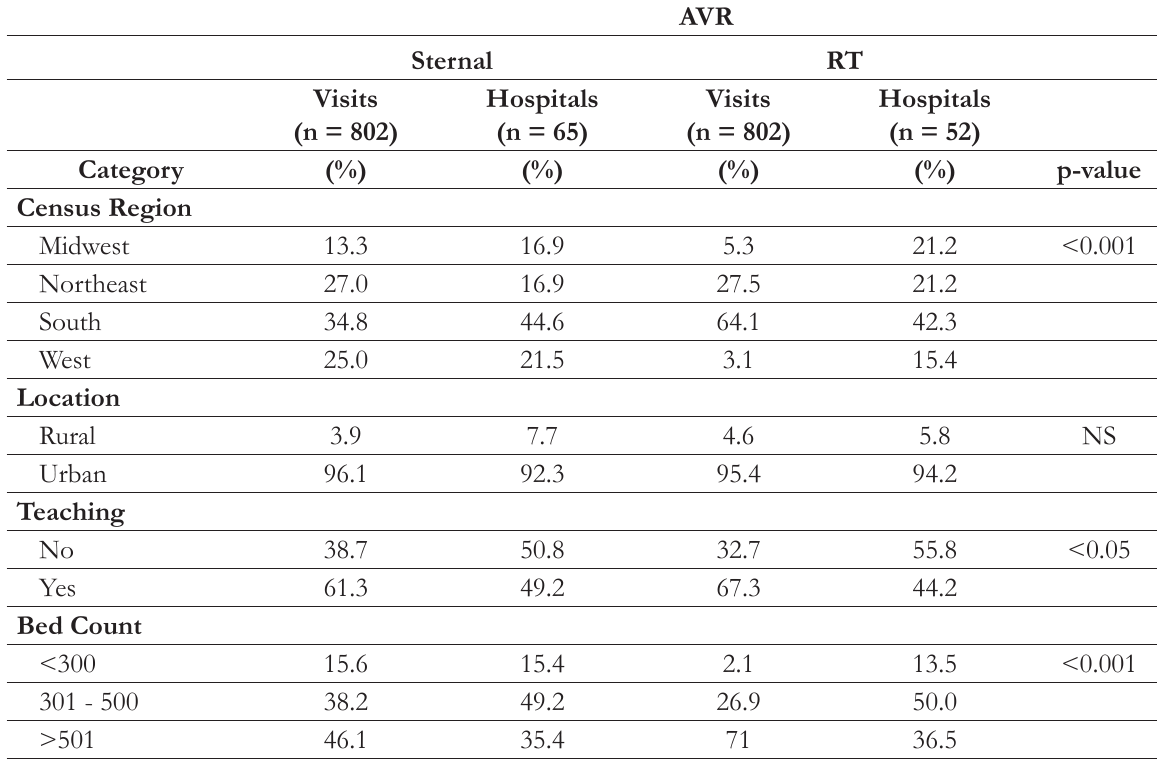
Table 3. Hospital Characteristics After Matching by Valvular Procedure AVR Sternal RT Visits (n = 802) Category